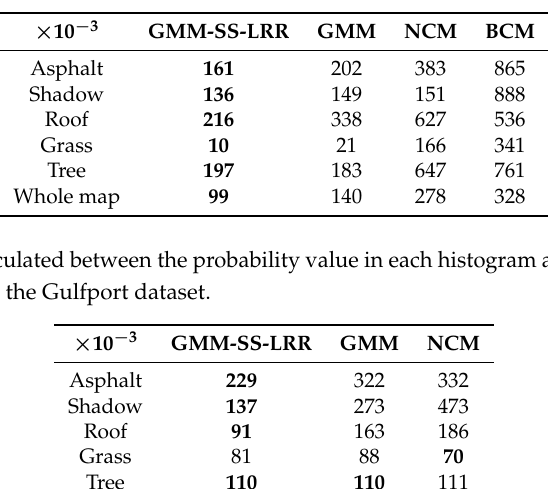
Figure 9. Histograms of pure pixels for the Gulfport dataset and the estimated distribution from GMM-SS-LRR, GMM and NCM when projected to one dimension. Table 3. Abundance errors for Gulfport dataset.